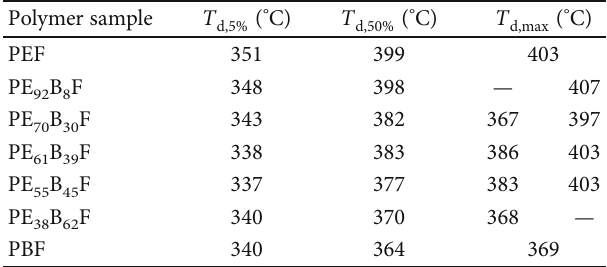
Table 4: Decomposition temperatures of PEF, PBF, and PEF-co- PBFs. Polymer